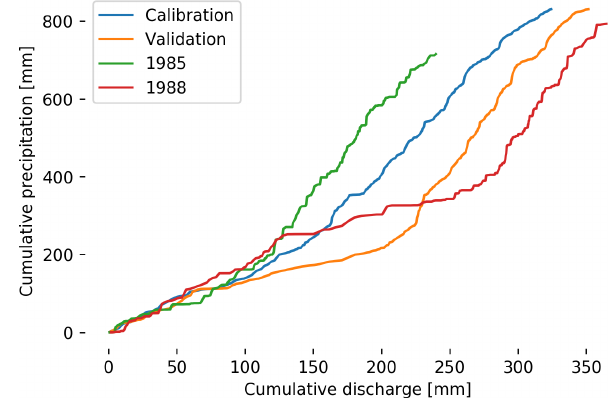
Figure 2. Cumulative discharge plotted against cumulative precip- itation for the calibration (1980–1985) and validation (1986–1988) period and 2 years which deviate most from the other years. For the calibration and validation period, the cumulative discharge and precipitation are the average of the corresponding